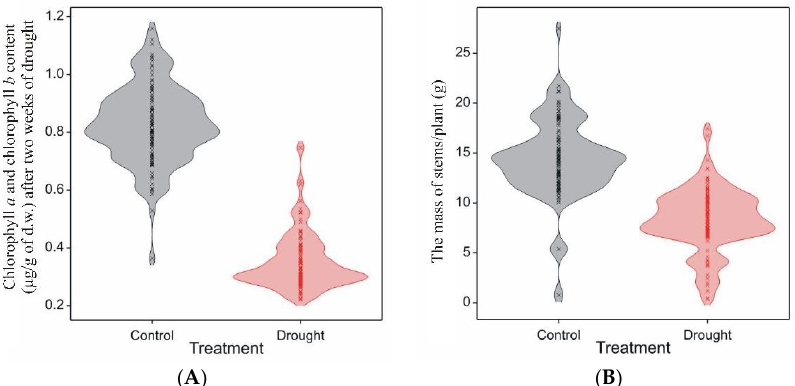
Figure 2. ( A ) The density plot of chlorophyll a and chlorophyll b content (µg/g of d.w.) after two weeks of drought for treatments. ( B ) The density plot of the mass of stems/plant (g) for treatments.